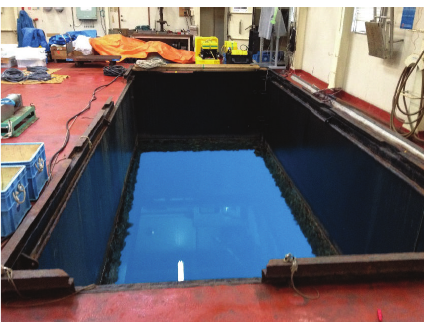
Figure 10: The moon pool inside the barge.